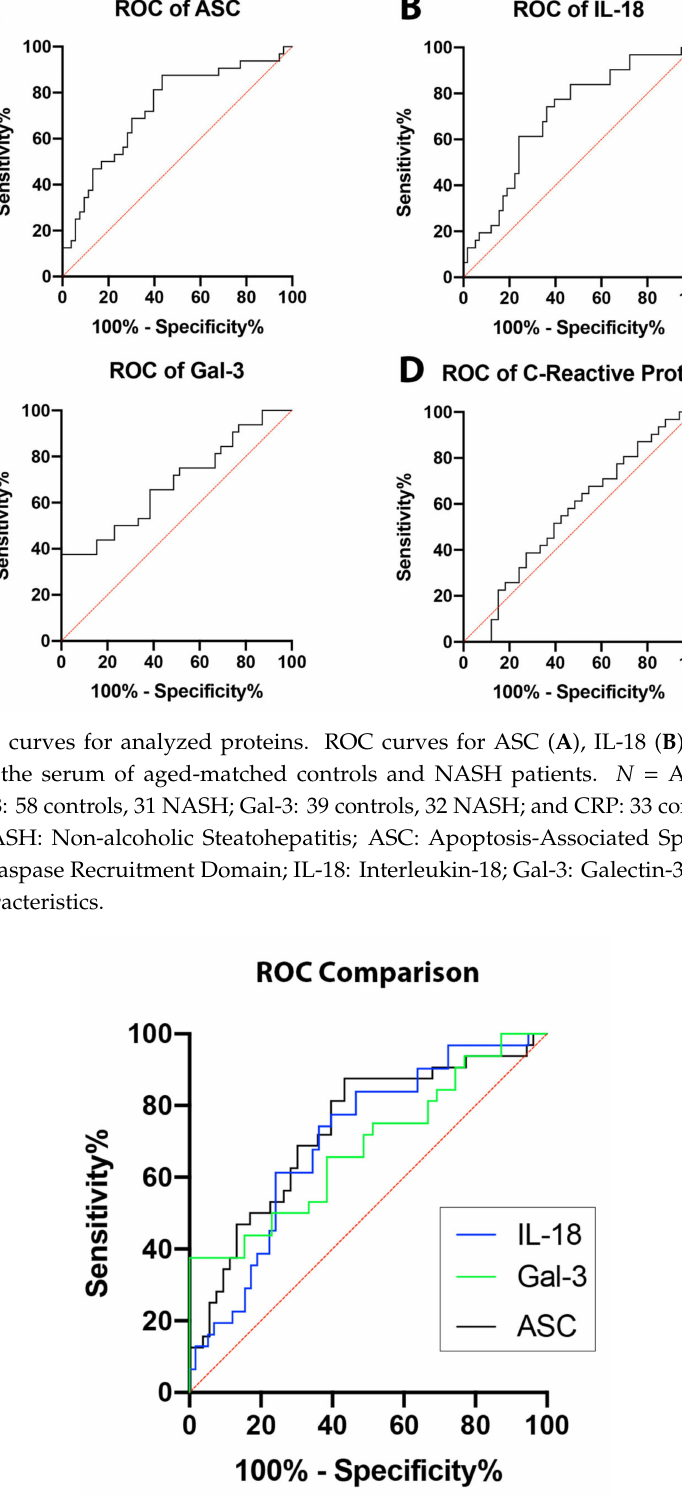
Figure 3. Inflammasome proteins as potential biomarkers for NASH. Comparison of ROC curves for ASC (black), IL-18 (blue), and Gal-3 (green). N = ASC: 53 controls, 32 NASH; IL-18: 58 controls, 31 NASH; Gal-3: 39 controls, 32 NASH. ROC: Receiver Operating